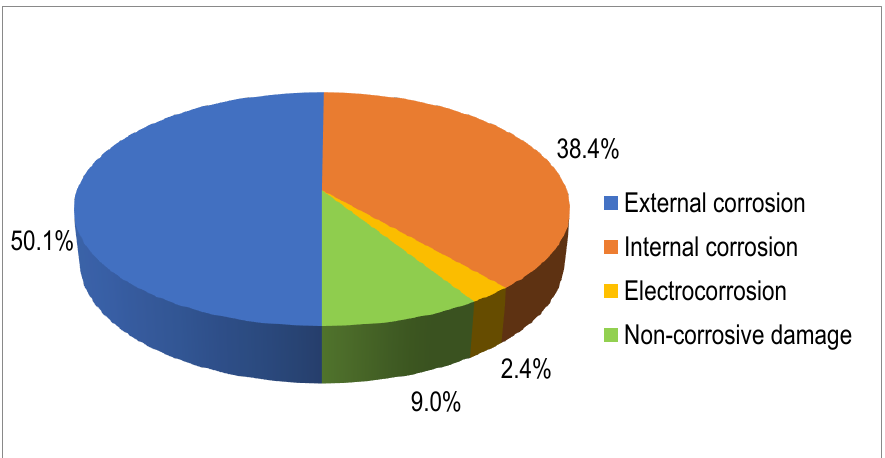
Figure 2. Distribution of causes of damage in backbone networks for the period from 2015 to 2020.